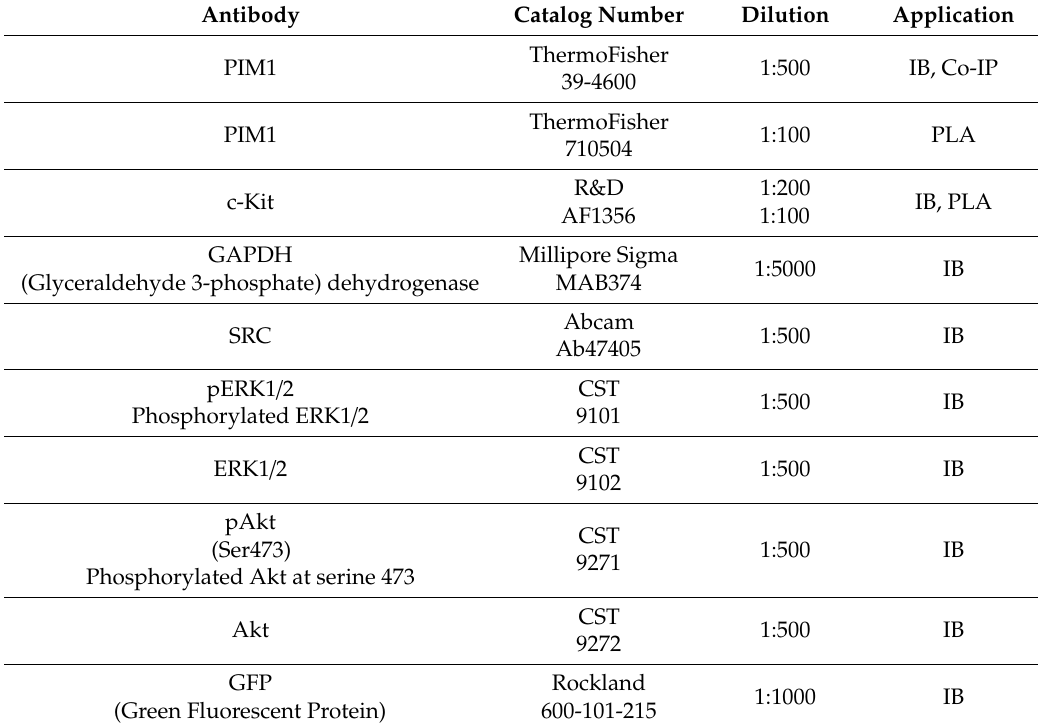
Table 1. Antibody